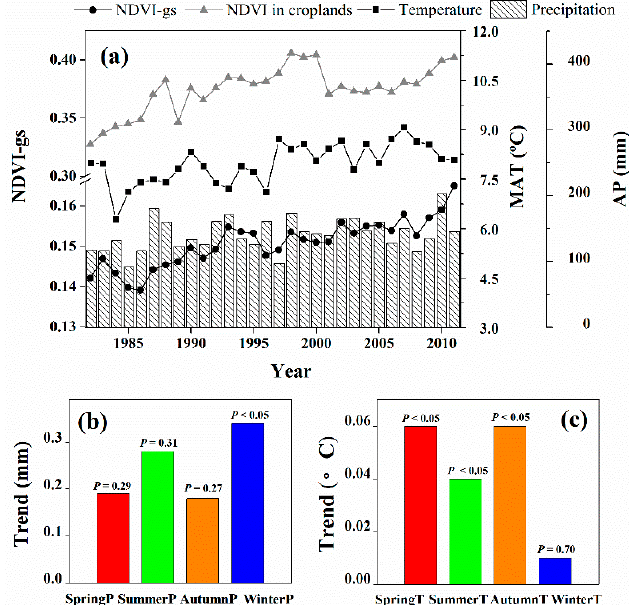
Figure 2. Linear trends in ( a ) NDVI-gs (Normalized Difference Vegetation Index, where gs refers to the growing season from April to October) without cropland (y = 0.001x + 0.1417, R 2 = 0.77, p < 0.001), NDVI in cropland (y = 0.0016x + 0.35, R 2 = 0.48, p < 0.001), mean annual temperature (MAT, y = 0.04x − 81.41, R 2 = 0.41, p < 0.001), and annual precipitation (AP, y = 0.99x − 1837.9, R 2 = 0.12, p = 0.06) during the period 1982–2011; Trends of ( b ) seasonal precipitation (mm per year): spring precipitation (spring P, p = 0.29), summer precipitation (summer P, p = 0.31), autumn precipitation (autumn P, p = 0.27), winter precipitation (winter P, y = 0.34x − 666.7, R 2 = 0.29, p < 0.05); and ( c ) seasonal temperature ( ° C per year): spring temperature (spring T, y = 0.06x − 119.1, R 2 = 0.25, p < 0.05), summer temperature (summer T, y = 0.04x − 63.6, R 2 = 0.44, p < 0.05), autumn temperature (autumn T, y = 0.06x − 115.5, R 2 =